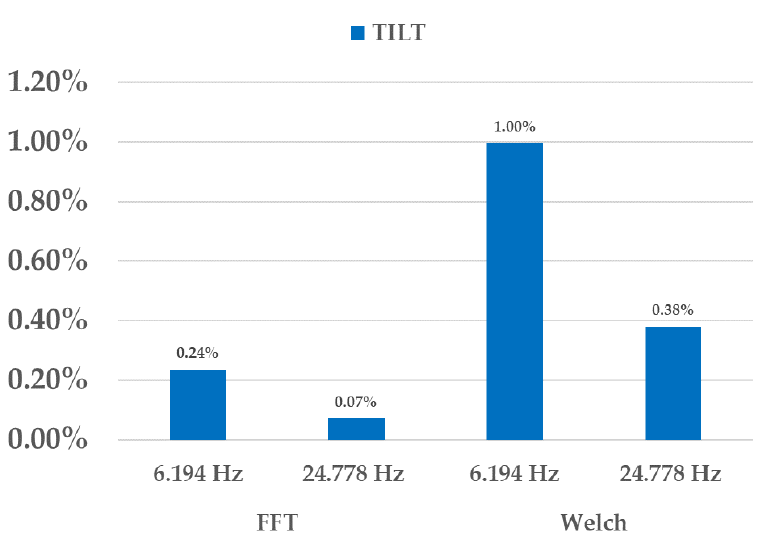
Figure 9. Spectral analysis on tilt values extracted by sensor node S2: comparison of the error distribution in vibrating modes extraction from acceleration and tilt signals via FFT and Welch strategy.